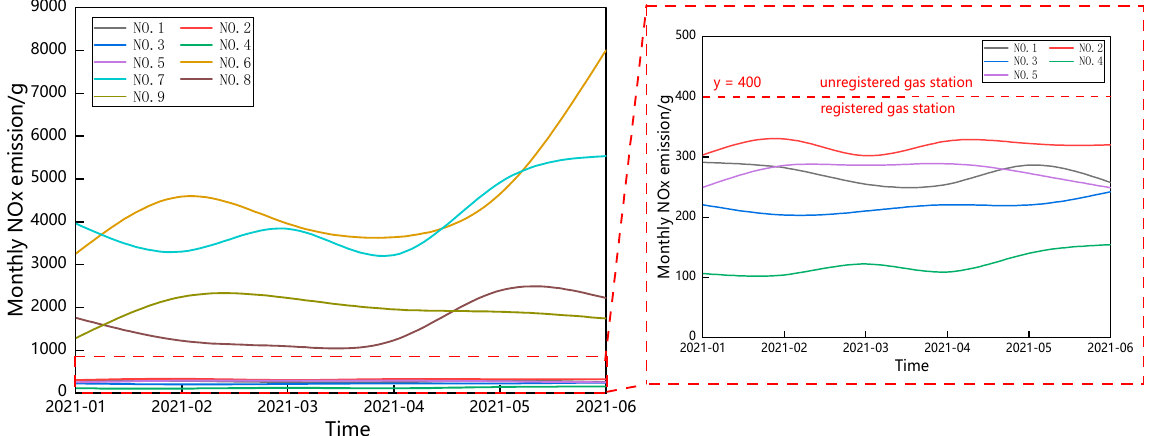
Figure 9. Emission trend change for 9 gas stations. Further, in order to analyze the stability of oil quality in the nine gas stations, the monthly average total NOx emissions per vehicle for these stations from January to June was calculated, as shown in Figure 9. It can be found that there is a significant difference between the monthly NOx emissions from both unregistered and legal gas stations. The average monthly emissions from unregistered gas stations fluctuate in range and have extremely large emission values, and the quality of the oil is extremely unstable. On the contrary, legal gas stations are below 400 g and remain largely stable over time. Based on